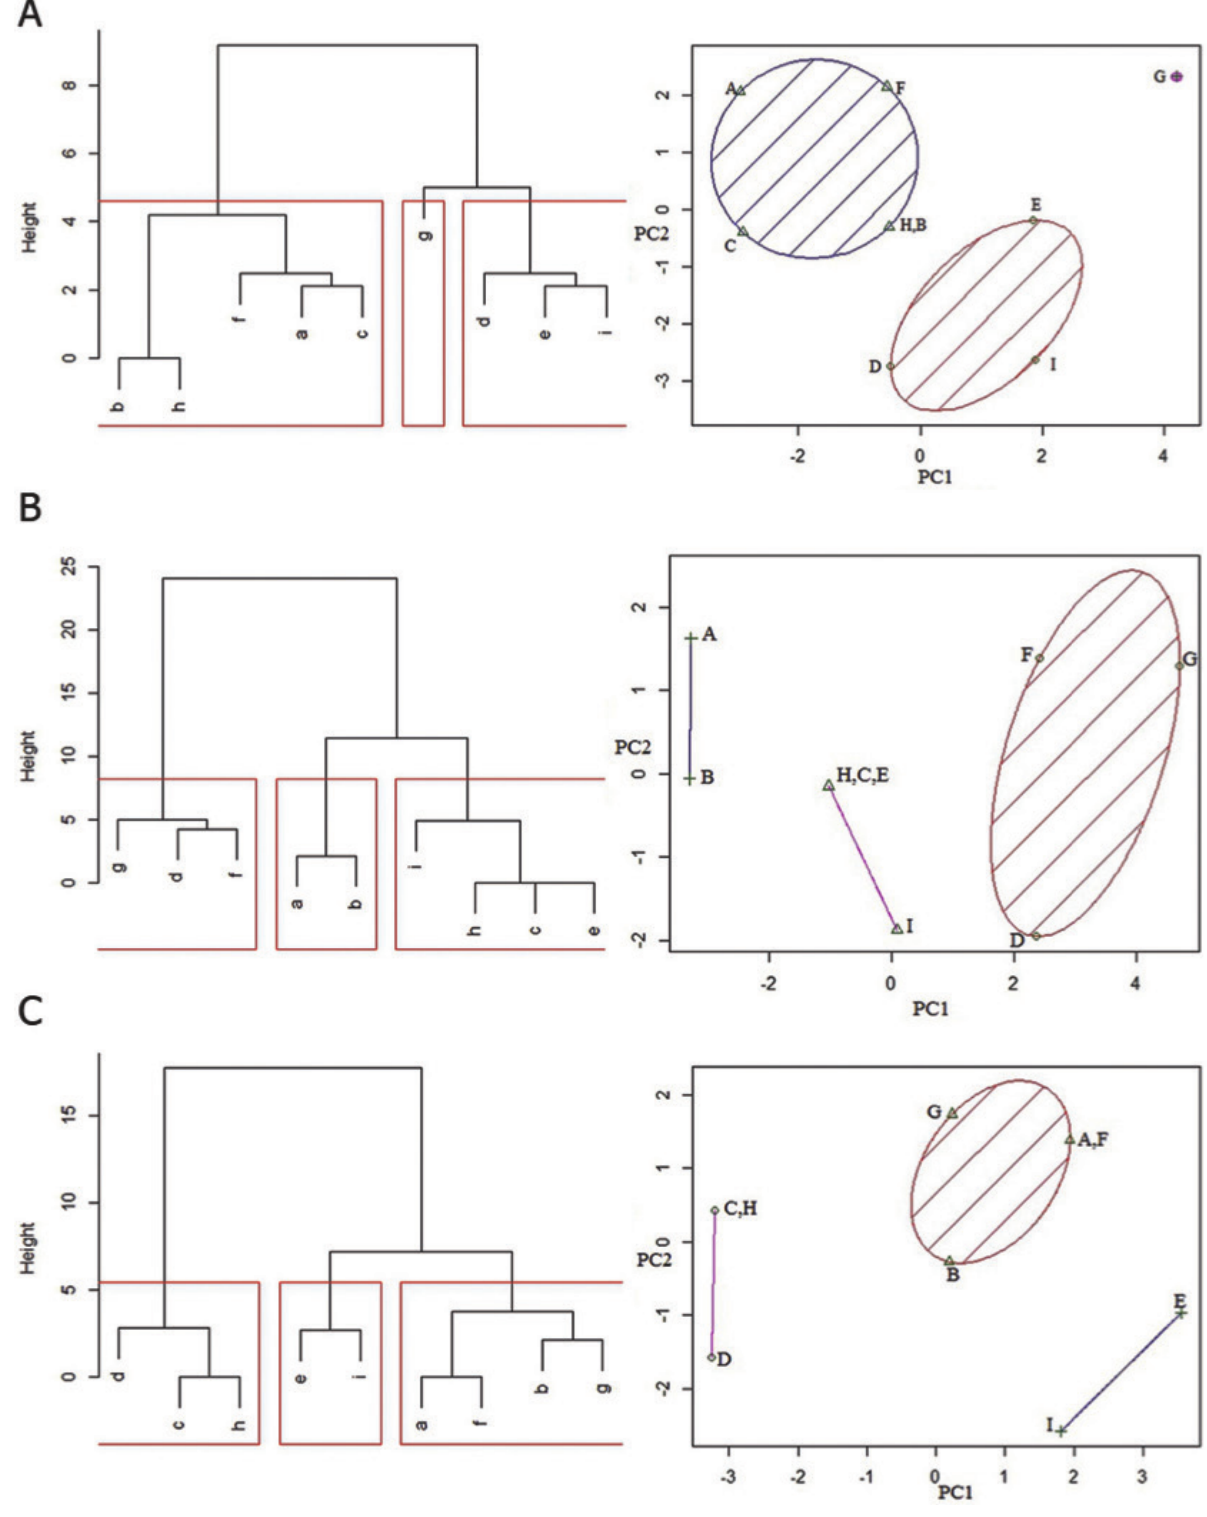
Figure 2: Dendrogram of classified genotypes using cluster analysis. A: S1 (4.5 ds/m) vs. S3 (10.5 ds/m), B: S1(4.5 ds/m) vs. S4(13.5 ds/m), C: S1(4.5 ds/m) vs. S5(16.5